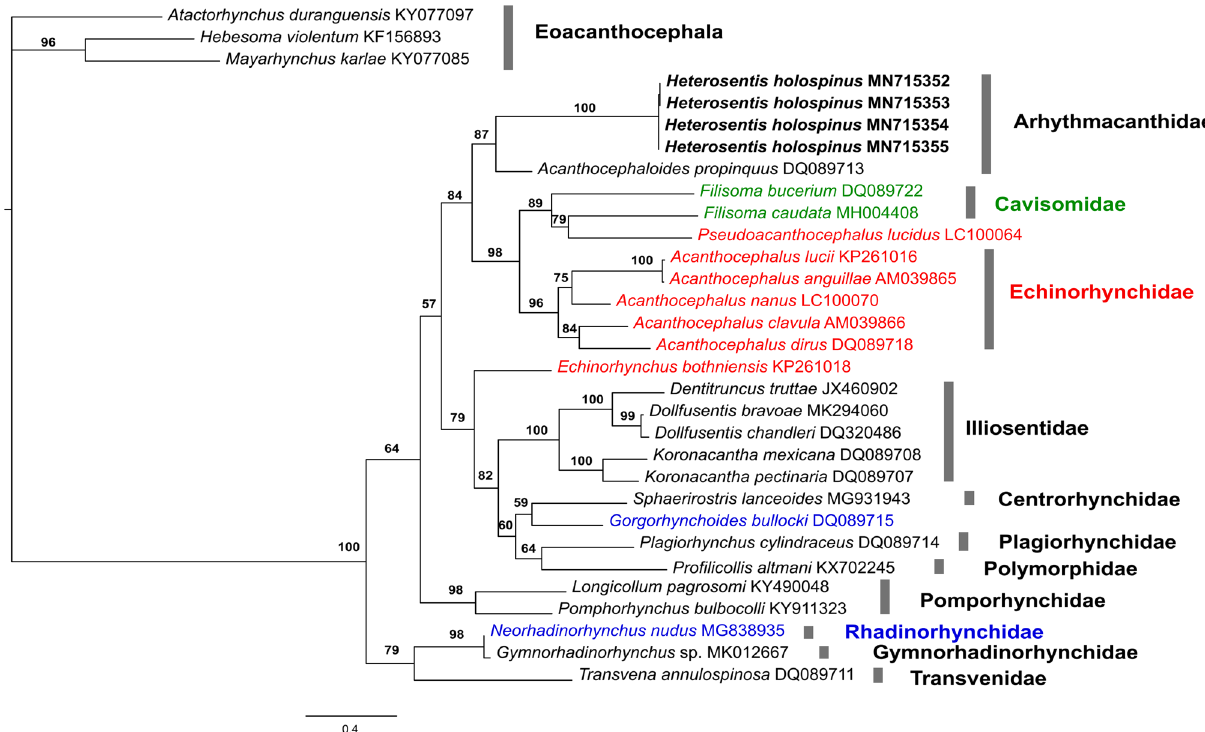
Figure 9. Genealogical relationships of haplotypes of the cox 1 gene of specimens of Heterosentis holospinus and specimens of Class Palaeacanthocephala recovered in a maximum likelihood analysis ( L n = (cid:2) 11,079.294). Support values, only given for species and multispecies clades, correspond to SH-aLRT test and ultrabootstrap proportions. The number below the internal nodes shows ML bootstrap support values. The clades with different colors, Echinorhynchidae (red), Cavisomidae (green), and Rhadinorhynchidae (blue) indicate a paraphyletic arrangement. GenBank accession numbers are also given at the terminal labels and bolded names were generated in this